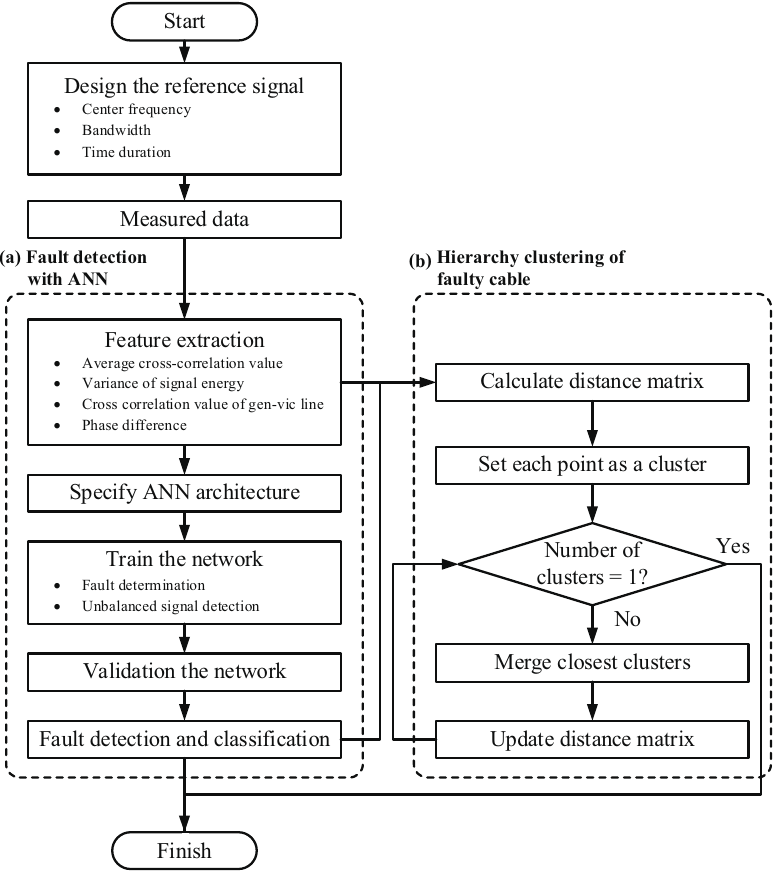
Figure 3. Fault detection and classification process with clustering